Question: Briefly state, in one sentence, what is plotted here.
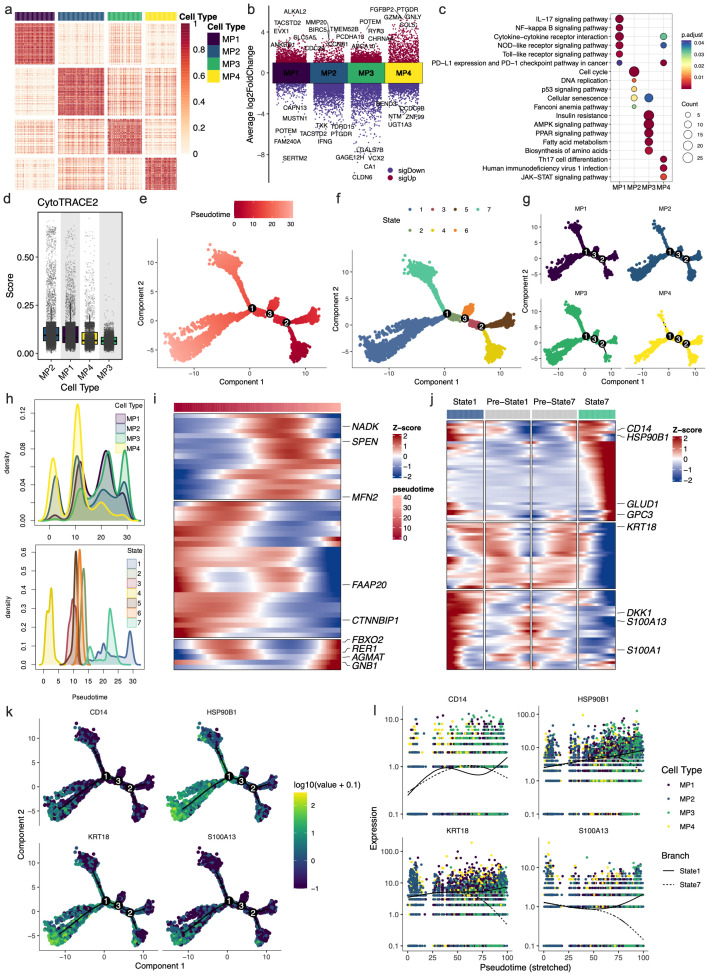
Answer: Pseudotime analysis reveals the dynamic transition trajectory of HCC malignant epithelial cells. (A) GeneNMF identified 4 programs from malignant cells. (B) DEGs between different programs were analyzed using the Wilcoxon rank-sum test. (C) GO functional enrichment analysis of DEGs between programs, highlighting representative signaling pathways. (D) CytoTRACE analysis of differentiation states among different programs. (E) Developmental pseudotime analysis inferred from Monocle. (F) Cell-state distribution inferred from Monocle analysis. (G) Distribution characteristics of different programs and cell states along pseudotime. (H) Distribution of different programs as inferred by Monocle analysis. (I) Dynamic transcriptional features of key genes along pseudotime. (J) BEAM analysis identifying key transition node DEGs. (K) Expression distribution of selected genes along pseudotime. (L) Expression distribution of selected genes along pseudotime in different branches.